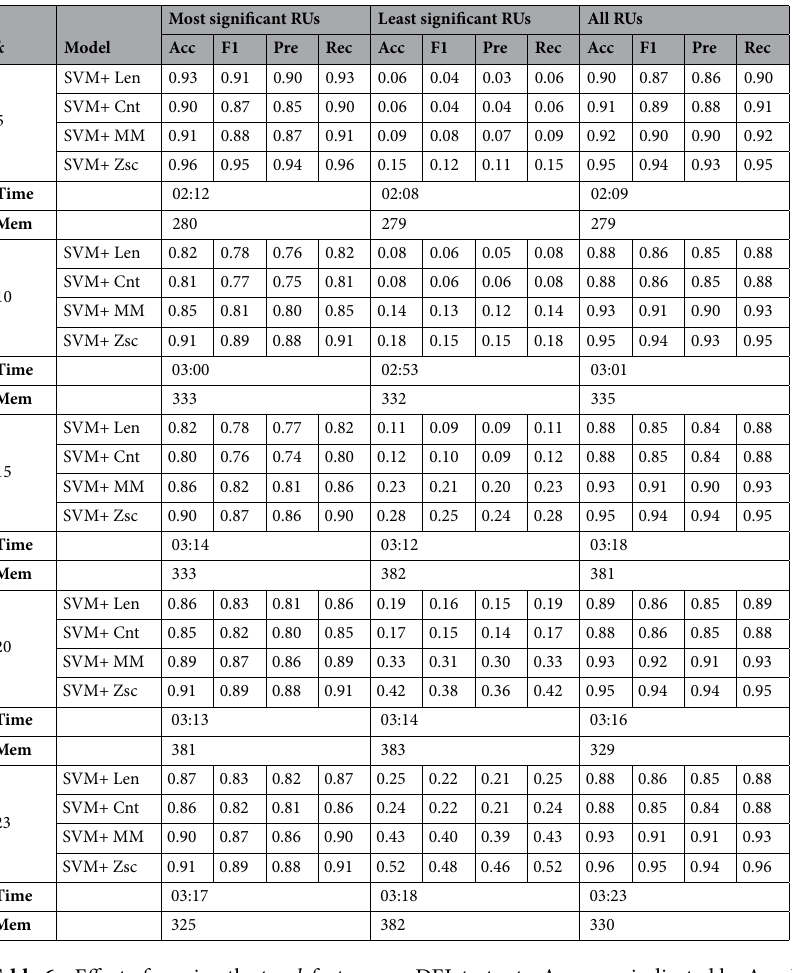
Table 6. Effect of varying the top k features on DEL test sets. Accuracy indicated by Acc, F1-score indicated by F1, Precision indicated by Pre, and Recall indicated by Rec. Also, the time is reported in the format mm:ss while the peak memory usage is in Megabytes.